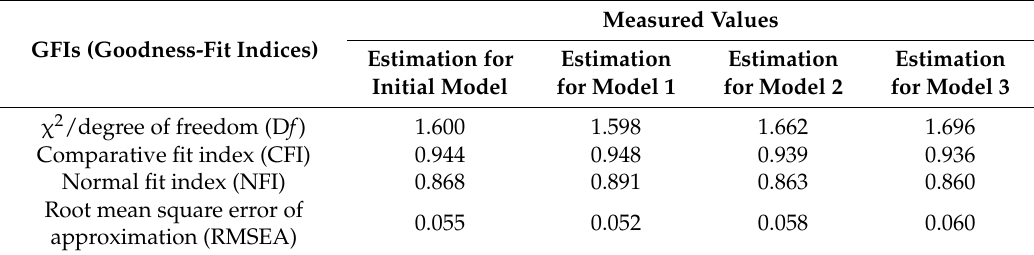
Measured Values Estimation for Estimation Estimation Estimation Initial Model for Model 1 for Model 2 for Model 3